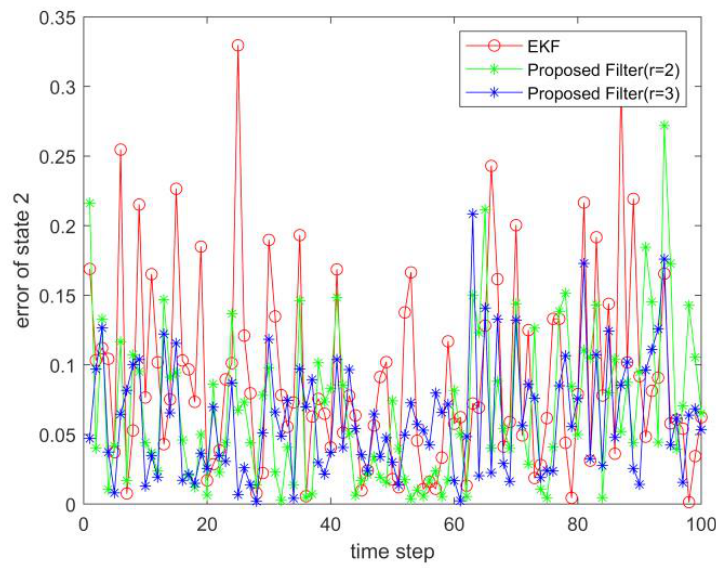
Figure 3. Estimation error of state 1.